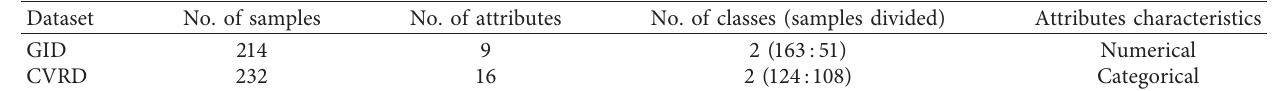
Table 1: Dataset description.